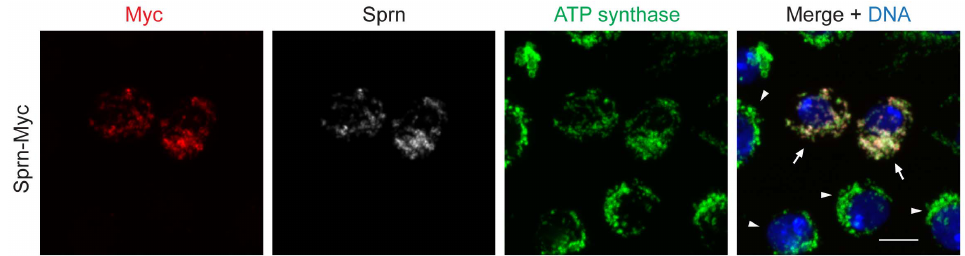
Table 1. Lethal analysis of ectopic in vivo UAS-Sprn-GFP expression.